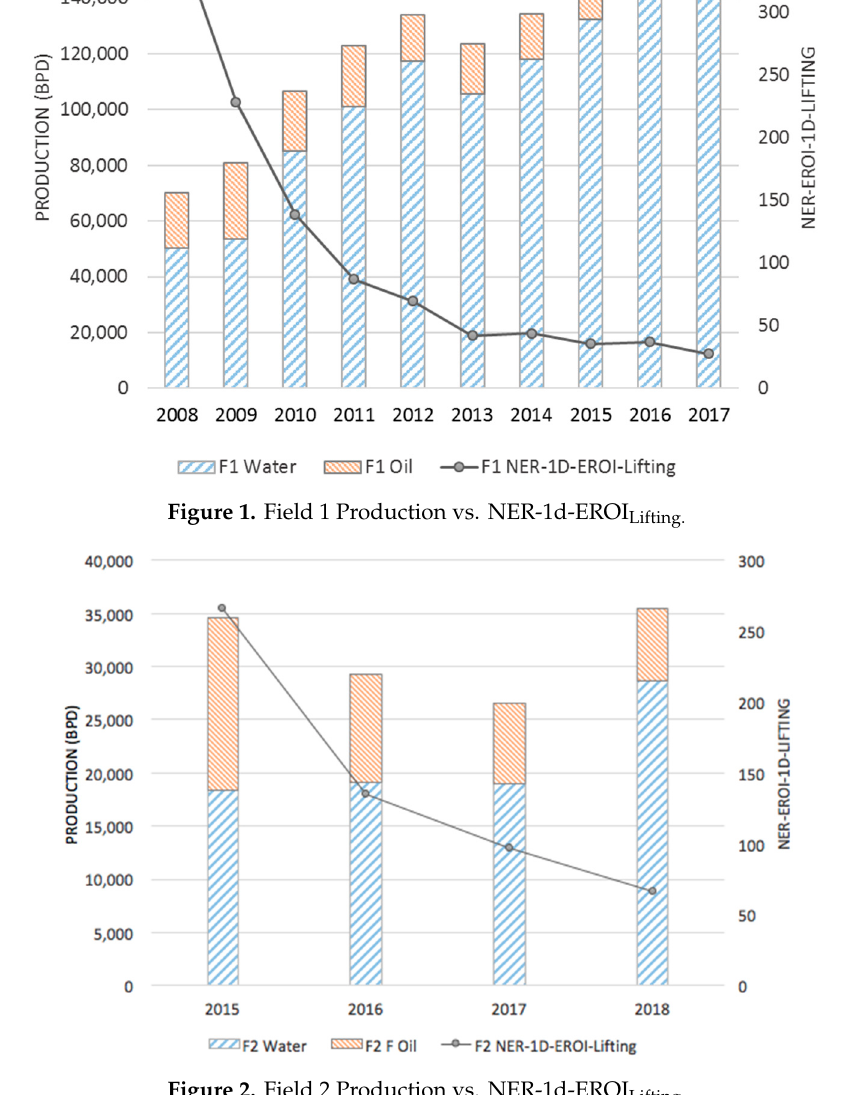
Figure 3. Field 3 Production vs. NER-1d-EROI Lifting. General trends for each field are shown in Table 5, indicating that all three fields experience decreasing NER-EROI-1d Lifting under similar production trends. Table 5. Trends for three small fields. Field